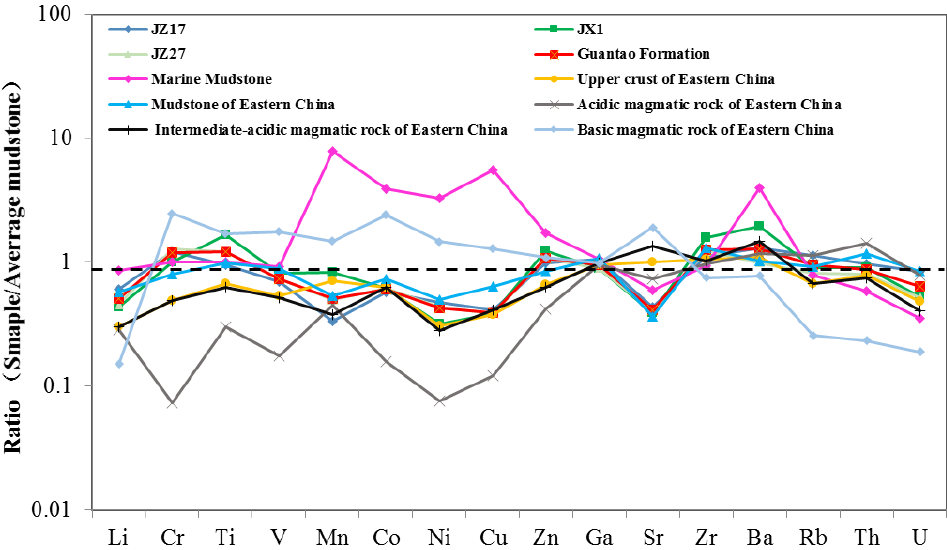
Figure 3. Trace element distribution patterns of the mudstones of the Neogene Guantao Formation in the Liaodong sub-uplift (data are normalized by the average mudstone values listed in Table 2).